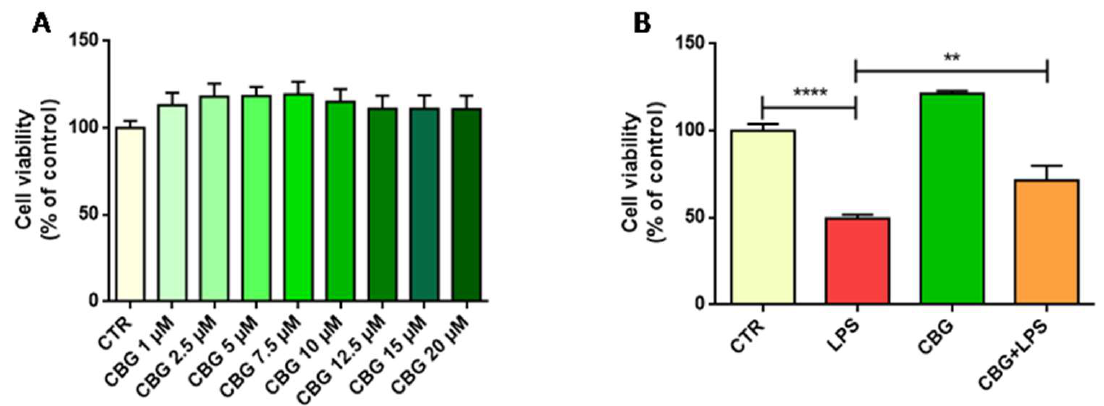
Figure 1. ( A ) Cell viability in NSC-34 motor neurons exposed to different CBG concentrations. All CBG doses increased cell viability compared to the control (CTR). ( B ) Cell viability in NSC-34 exposed to the medium of LPS-stimulated macrophages and in cells pre-treated with CBG. The